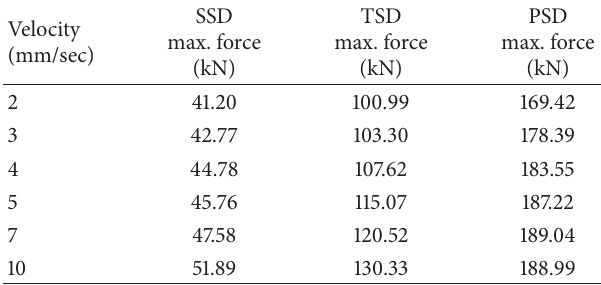
Table 1: Maximum damping forces of the